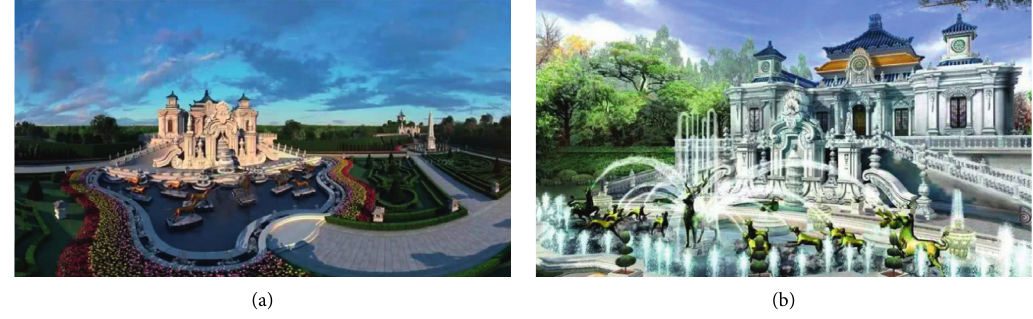
Figure 1: The 3D restoration of the old summer